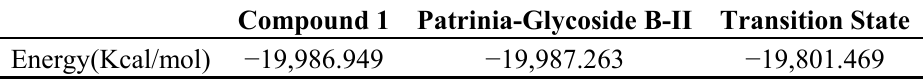
Table 1. The energy of compound 1 , Patrinia-glycoside B-II and Transition State.